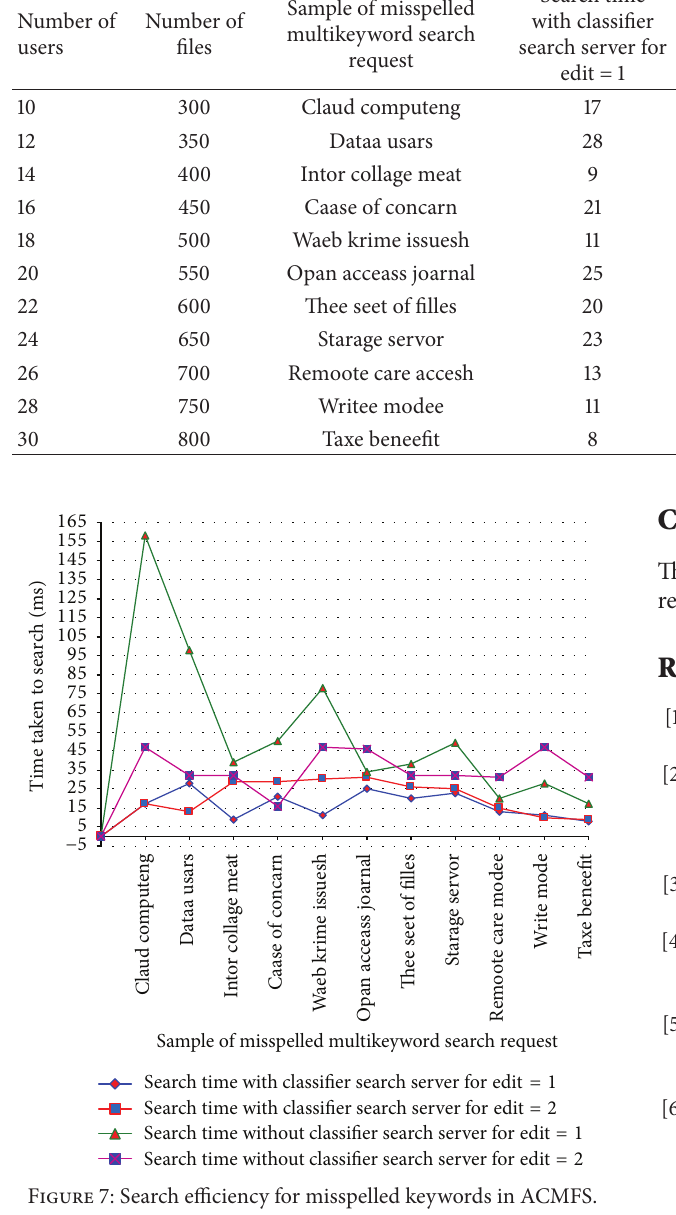
Figure 7: Search efficiency for misspelled keywords in ACMFS.